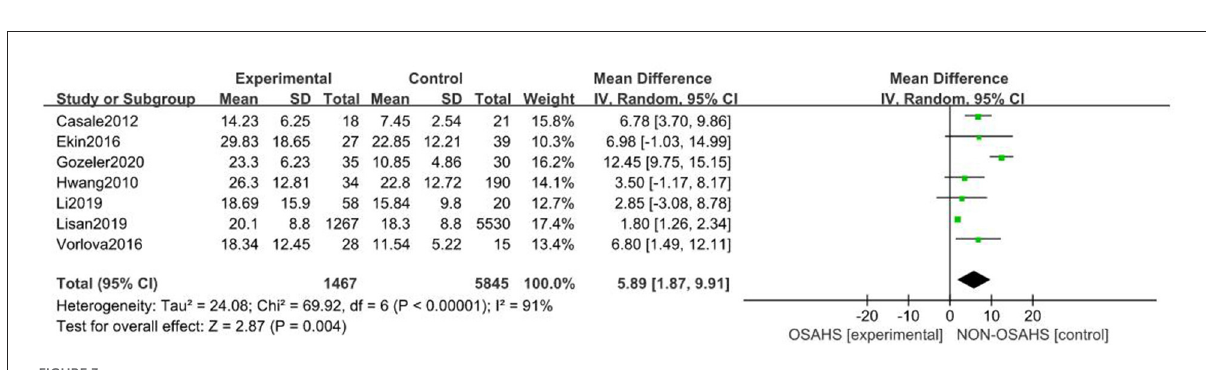
FIGURE3 Forest plot of pure-tone hearing threshold correlation between OSAHS group and control